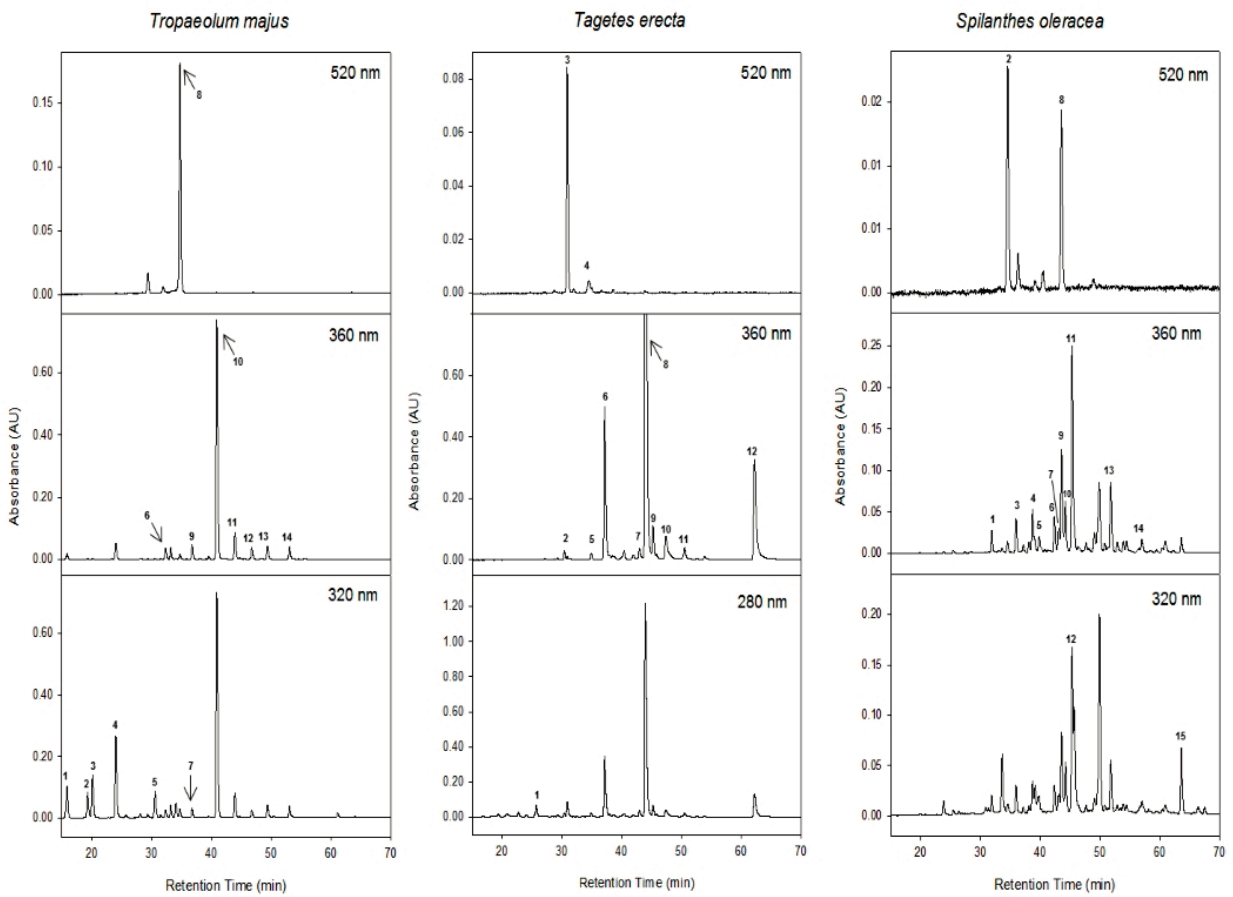
Figure 1. Chromatograms of the edible flowers recorded at 520, 360, 320 and 280 nm. Peak numbers are listed in Table